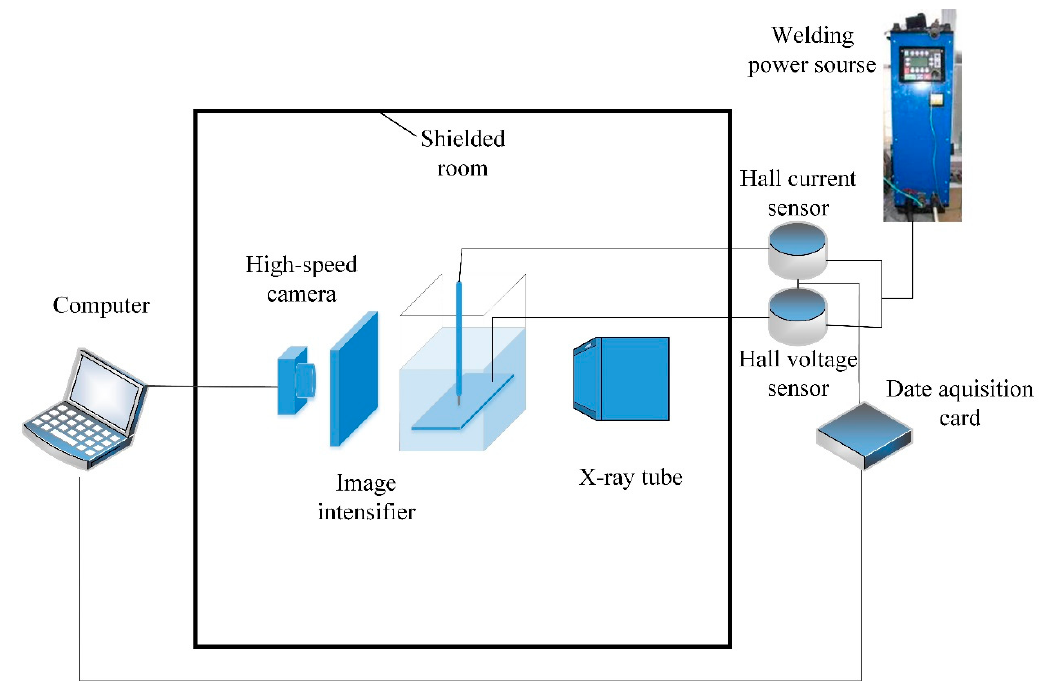
Figure 2. Experimental equipment schematic.